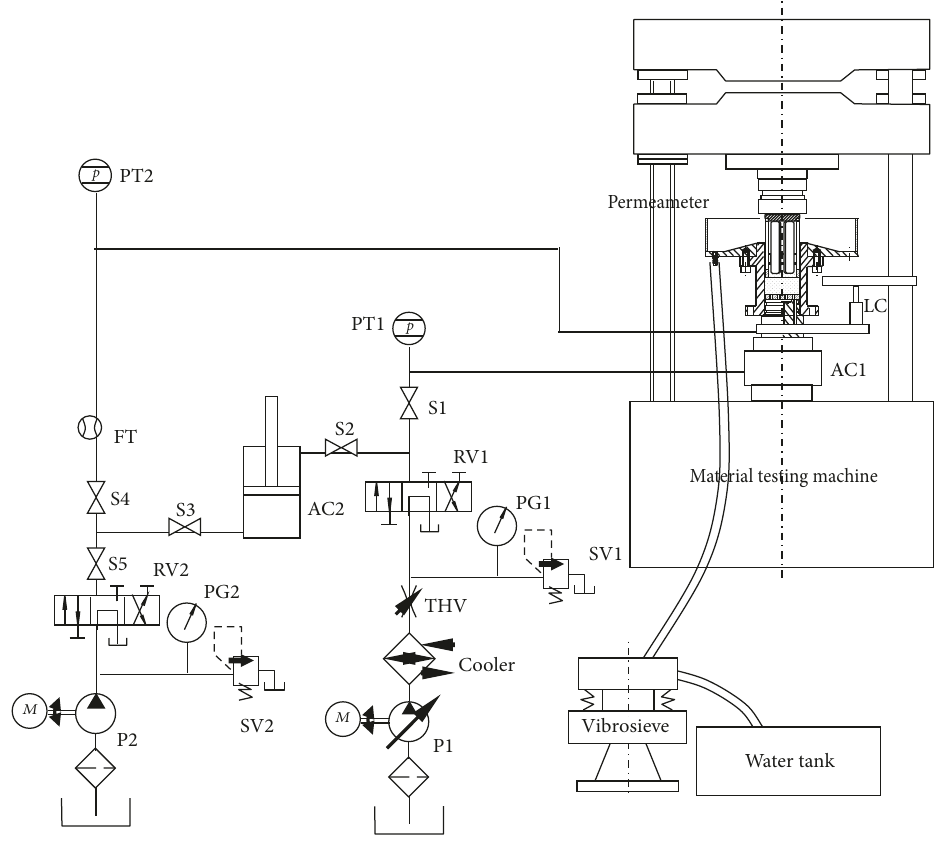
Figure 1: Schematic of the test